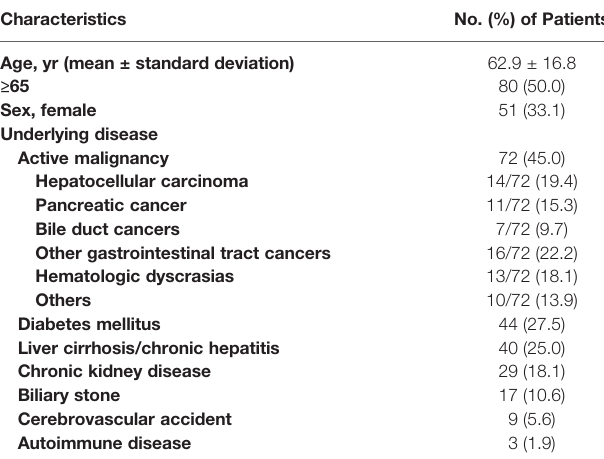
TABLE 1 | Demographics of 160 patients with clinical Aeromonas